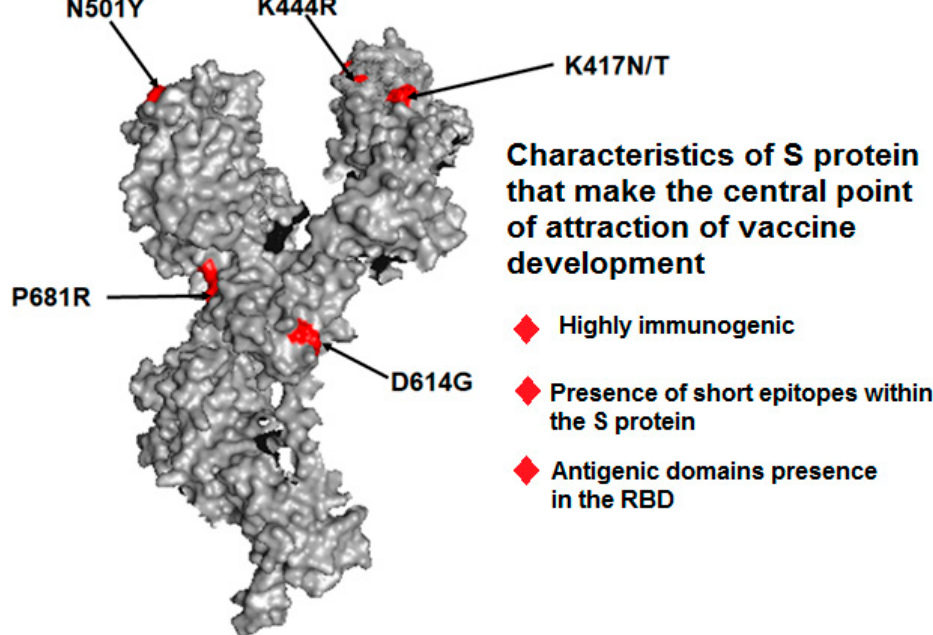
Figure 4. A spike protein’s 3D structure and its characters which make it the central point of attraction for vaccine development. Here, we depict some significant mutations in S proteins, such as P681R, N501Y, K444R, K41N/K, and D614G.